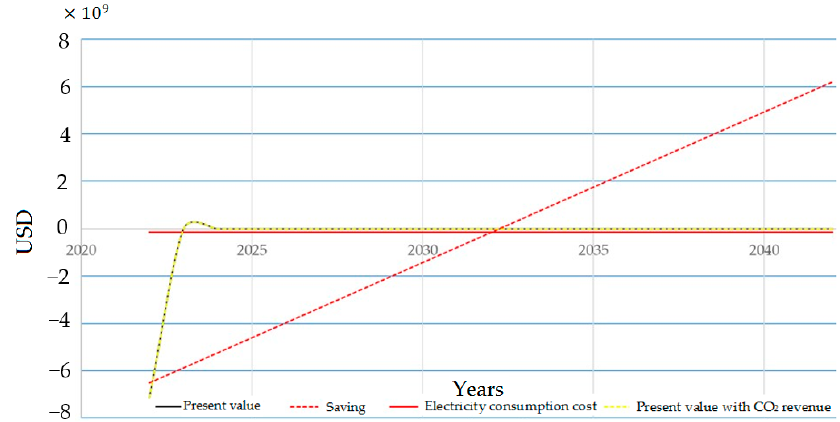
Figure 13. Payback period, net present value, and CO 2 emissions saving.